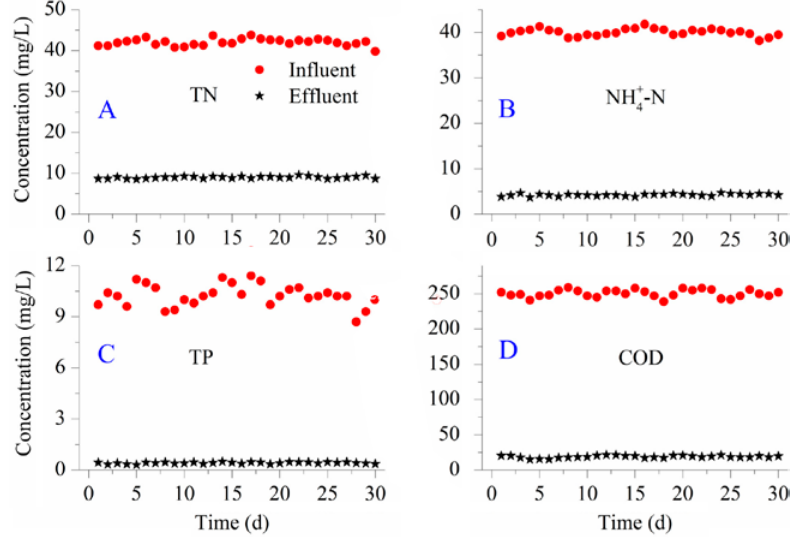
Fig. 2. Variations of COD, NH4-N, TN and TP in the influent and effluent and